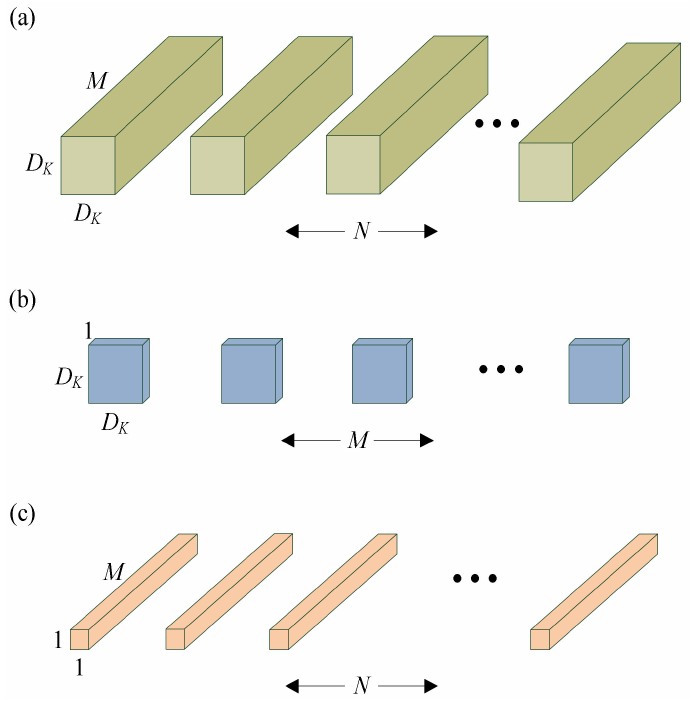
Figure 6. ( a ) Standard convolution filters; ( b ) depthwise convolutional filters; and ( c ) pointwise convolutional